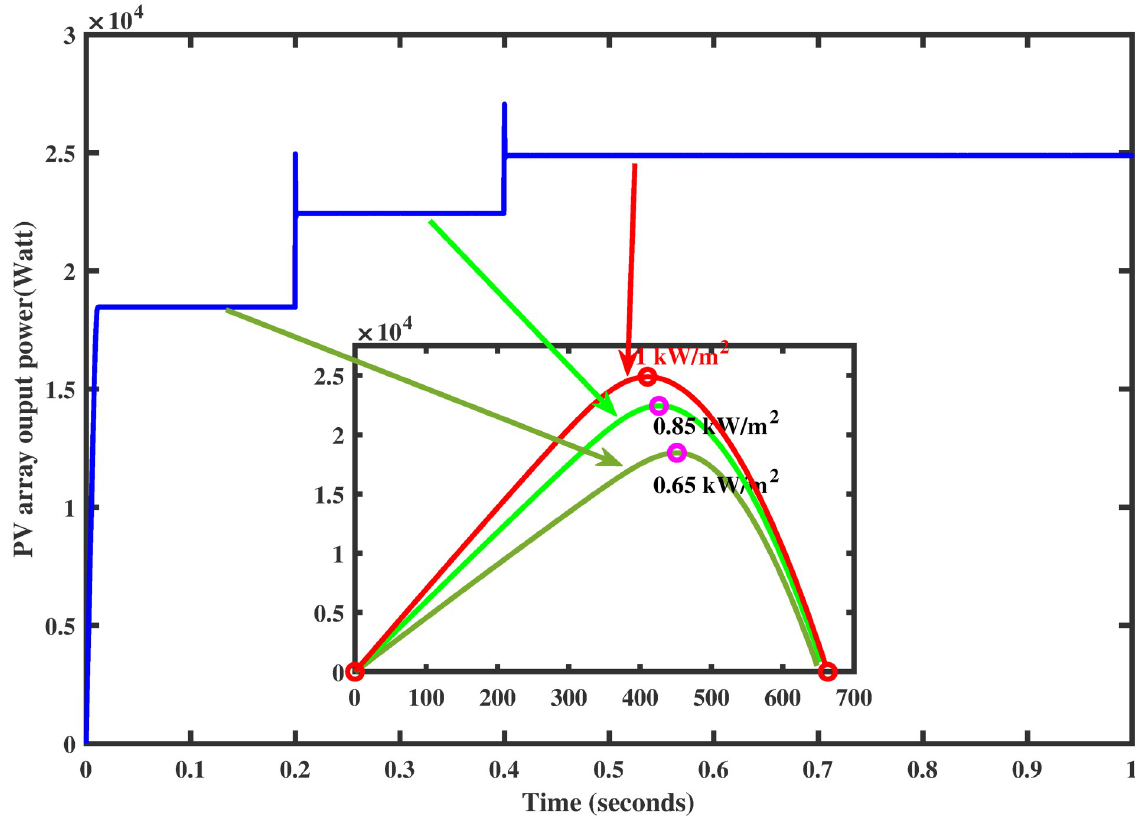
Fig 15. Tracking of V pv with respect to V ref under varying